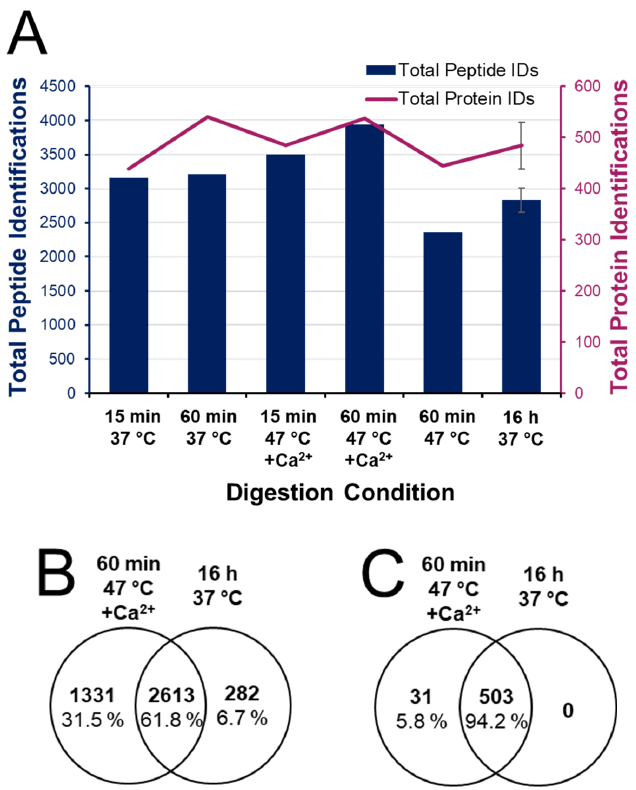
Figure 4. Qualitative bottom-up proteome identifications. ( A ) Total peptide and protein identifica- tions following digestions ranging from 15 min to overnight at 37 or 47 °C, with and without 10 mM added calcium chloride. Venn diagrams of ( B ) peptide and ( C ) protein identifications in the 1 h digest at 47 °C with 10 mM Ca 2+ are compared to the conventional overnight digest at 37 °C with no added Ca 2+ .